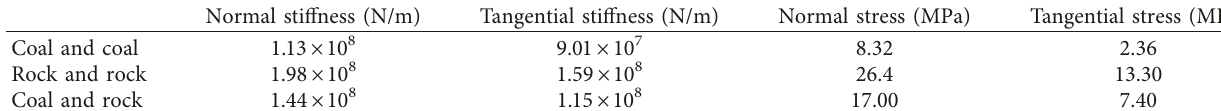
Table 3: Particle contact model parameters.